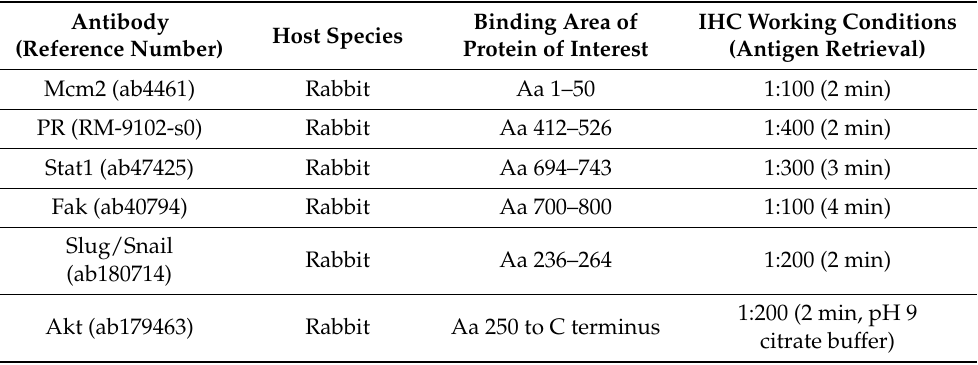
Table 1. Antibodies used in this study. Table shows the host species, target area of the protein which the antibody binds and the IHC conditions including stock dilution and the antigen retrieval times (performed in pH6 citrate buffer unless